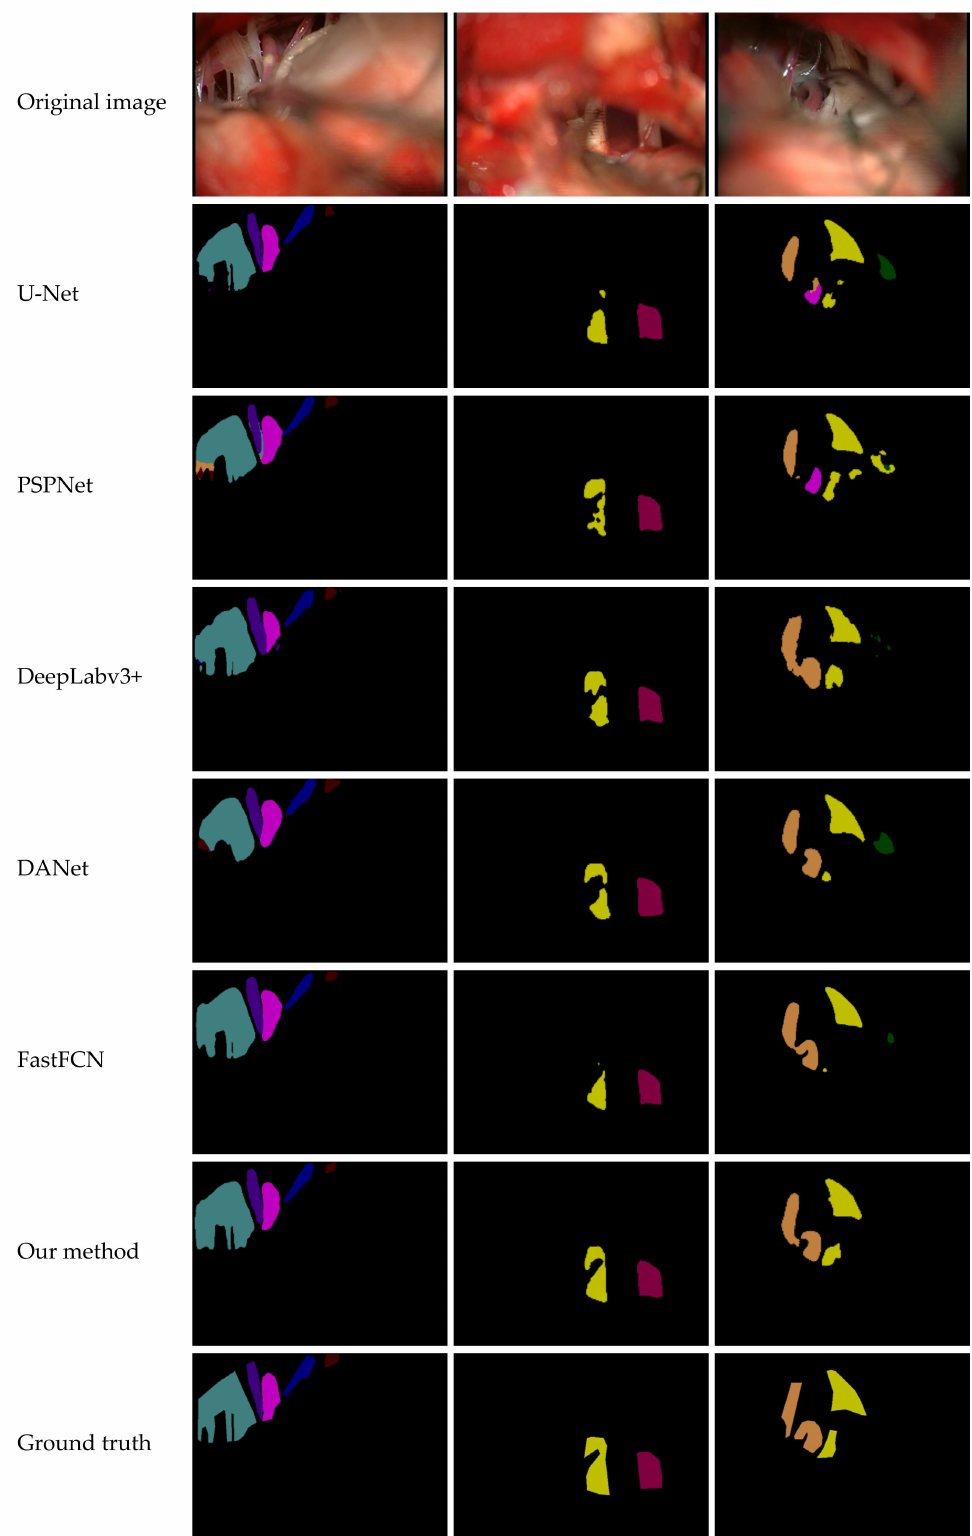
Figure 9. Experimental results and comparison with other